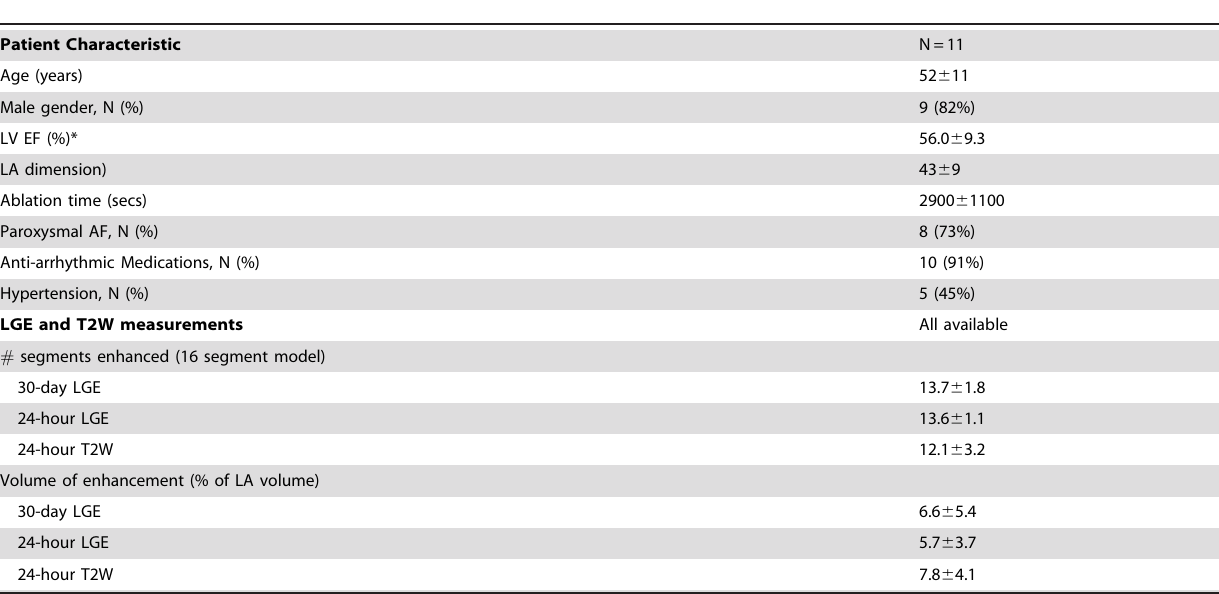
Table 1. Patient characteristics and MRI findings for patients with post-PVI imaging.